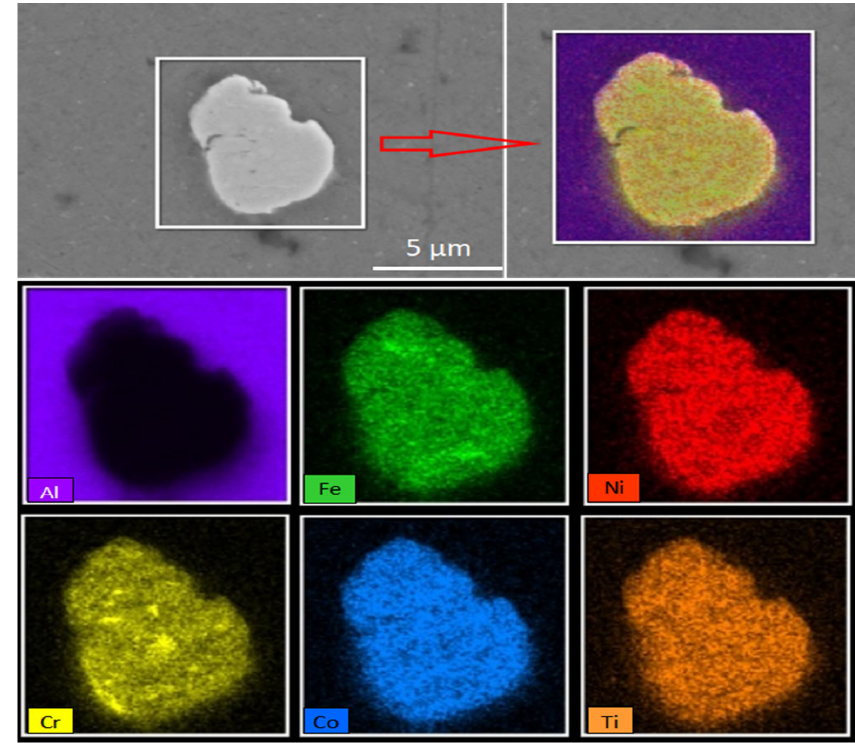
Figure 8. Surface scanning analysis of 10 vol.% HEA composites.